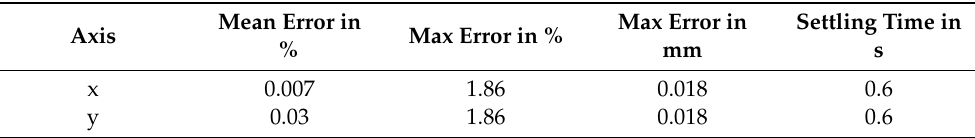
Table 2. Error metrics of the experiment with current controller dynamics and constant reference po-